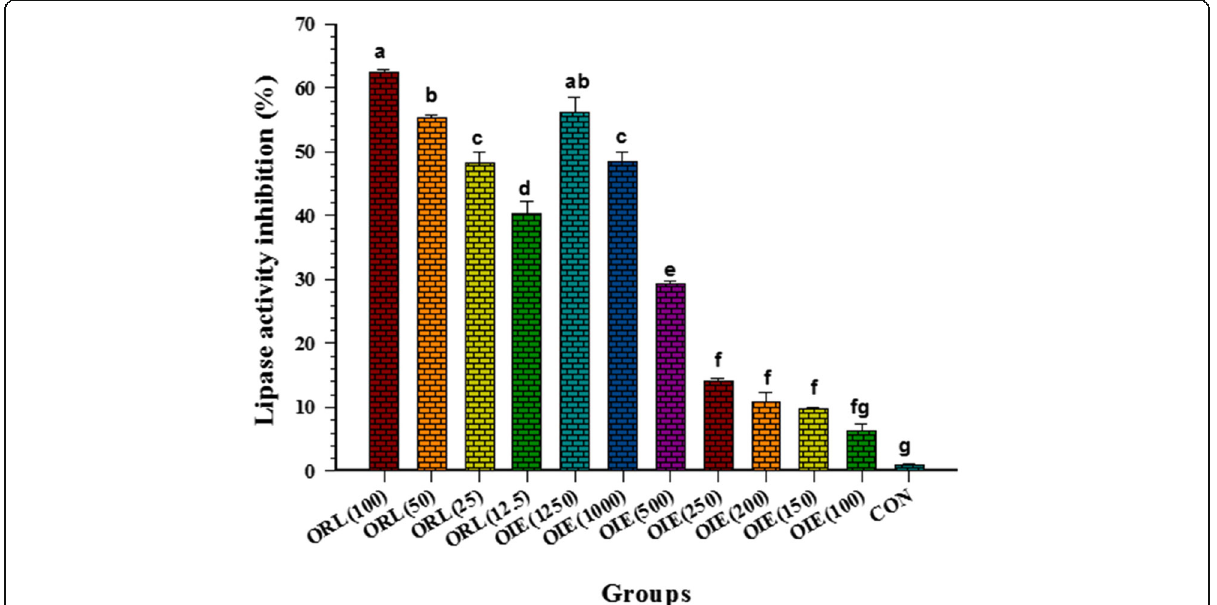
Fig. 10 Inhibitory effects of Oroxylum indicum extract compare to Orlistat on lipase activity. CON=Control; OIE(100)= Oroxylum indicum at 100 μ g/mL; ORL(12.5)= Orlistat at 12.5 μ g/mL. Orlistat was used as a positive control. Values are represented as Means ± SEM (n=3). A significant differences were observed (Tukey ’ s HSD test, p <0.05) and are represented on the figure with letters from a to g. Data suggests that Orlistat is 27 times more effective as inhibitor of lipase compared to